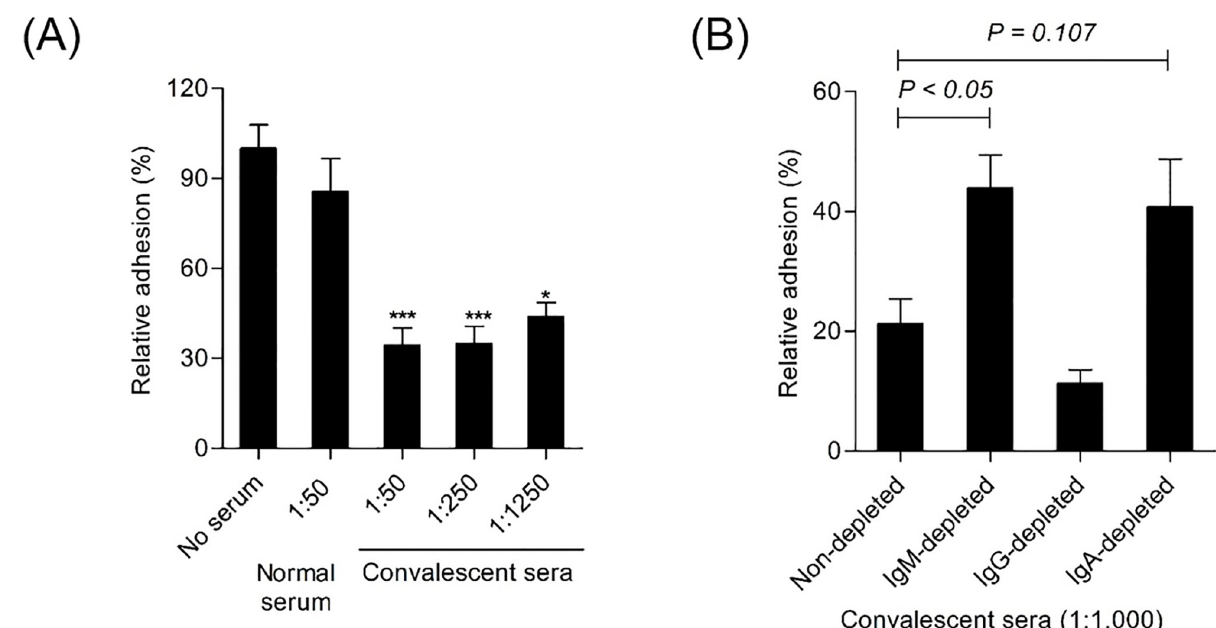
Fig 4. Convalescent sera, but not IgM-depleted sera, inhibited bacterial adhesion to intestinal epithelial cells. HT-29 cells (2 × 10 5 cells/ml) were cultured in a 24-well plate for 8 days until cells reached confluence. V . cholerae O1 Inaba (1 x 10 6 CFU/ml) was incubated with serially diluted convalescent sera (A) or antibody isotypes-depleted sera (B) for 1 h at 4˚C and added to HT-29 cells. After additional 1 h incubation at room temperature with gentle shaking, HT-29 cells were washed with PBS followed by treatment with 0.2% TritonX 100. Adherent bacteria were cultured overnight on LB agar plates and counted. Values are mean ± standard deviation of triplicate